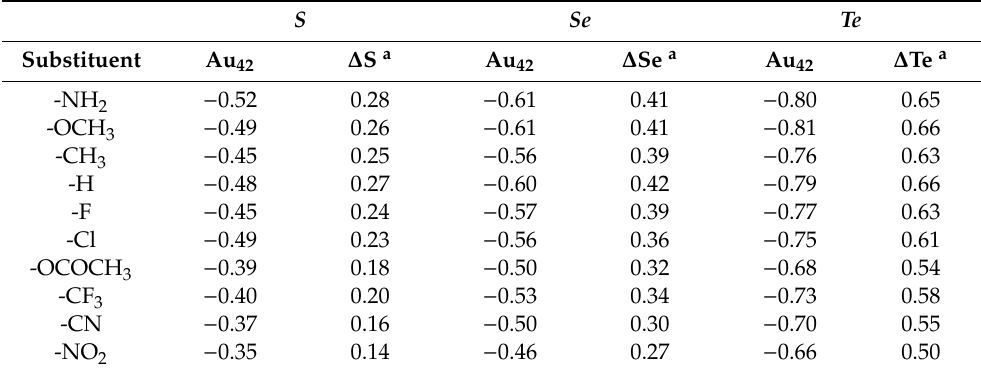
Table 4. Quantification of the charge transfer process between the ortho -substituted ligands and the gold-based substrate. These were obtained from the di ff erence between the NPA charges of the complexes and the free fragments.